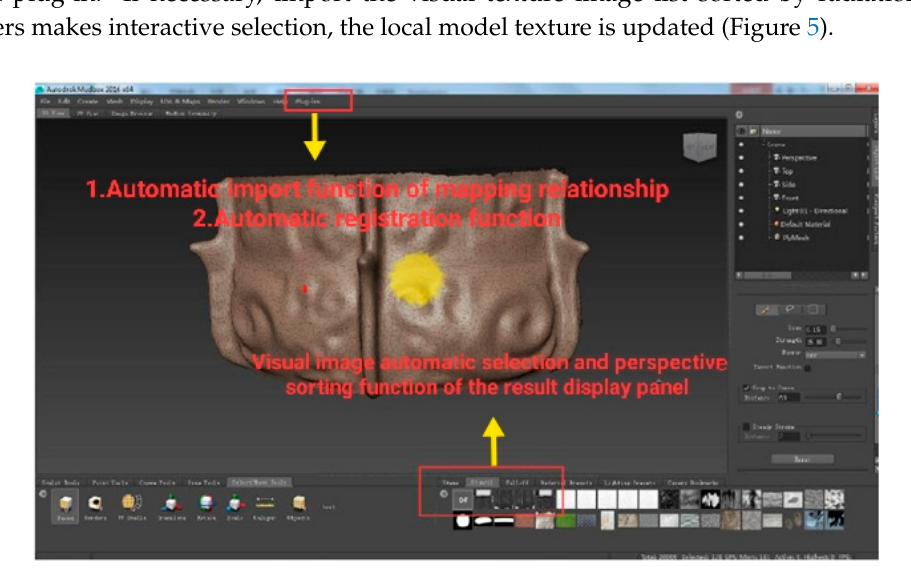
Figure 5. Interface of semi-automatic texture mapping under MudBox.